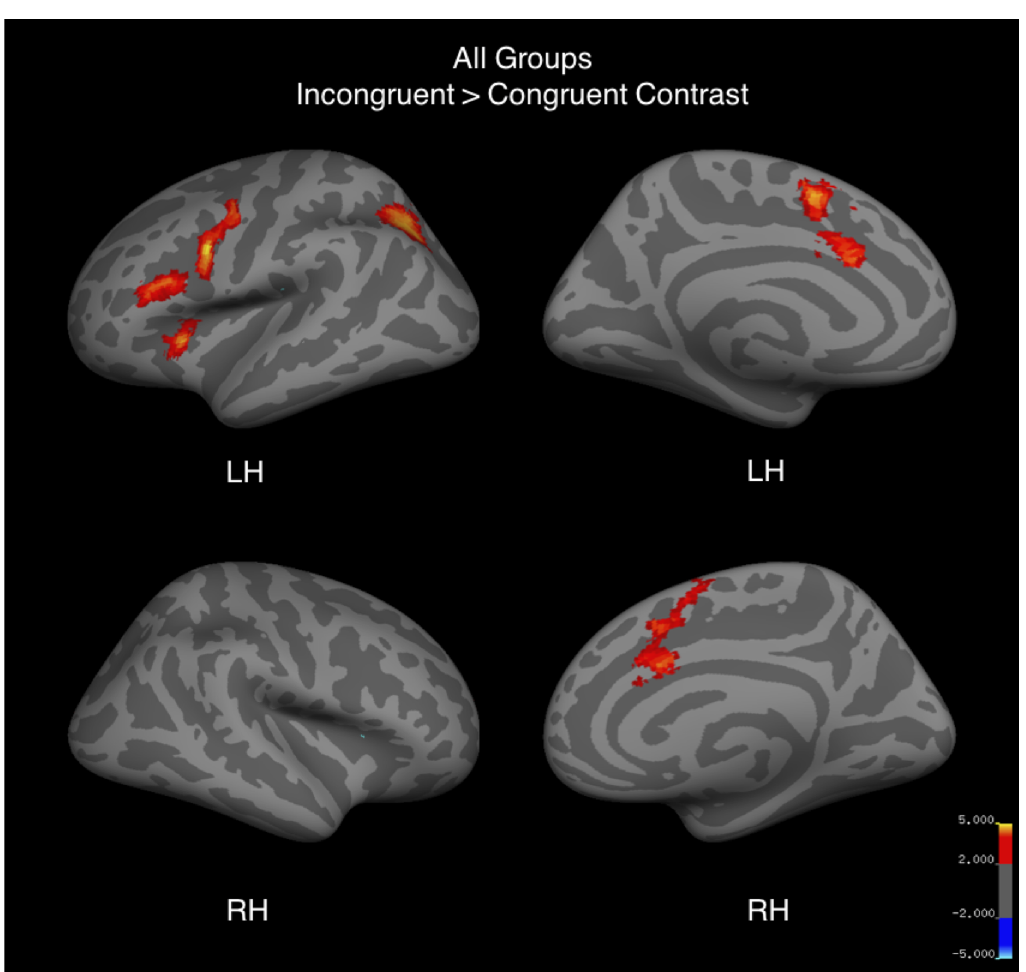
Fig 4. Whole brain activation for incongruent > congruent trials of the fMRI Color-Word Stroop task for all three groups. Red to yellow correspondsto positive z-values.Images are cluster thresholded at Z > 2.3 and cluster size threshold of p <